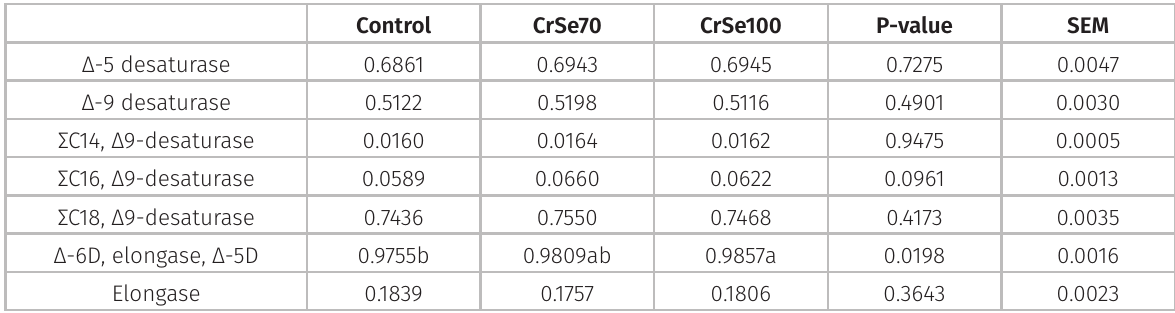
Table VII. Estimated enzyme activity of swine supplemented with organic chromium and